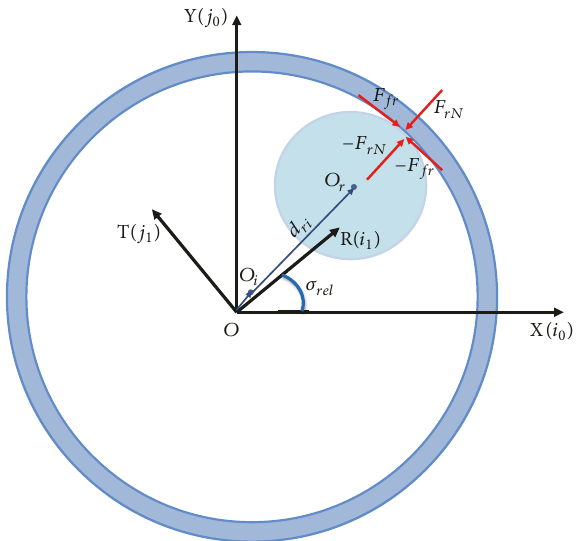
Figure 8: Interaction normal and friction forces between the rotor and the bearing inner